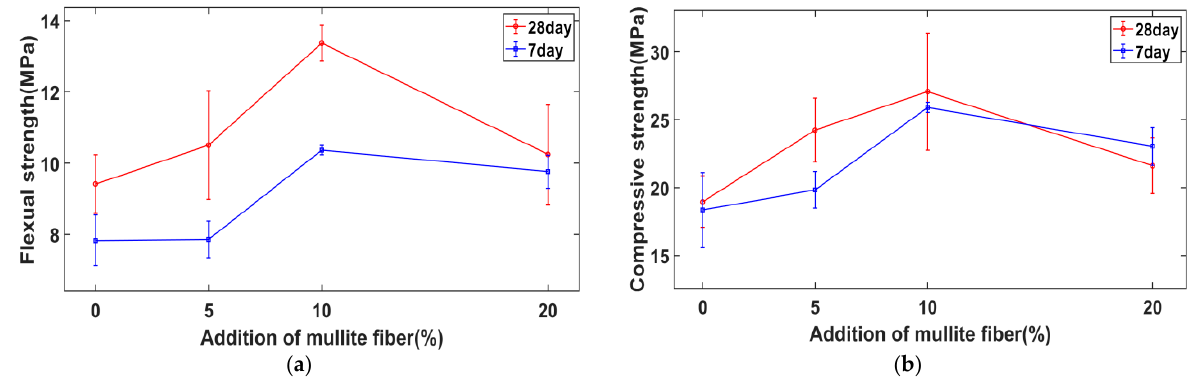
Figure 5. Flexural ( a ) and compressive ( b ) strength of geopolymer composites.